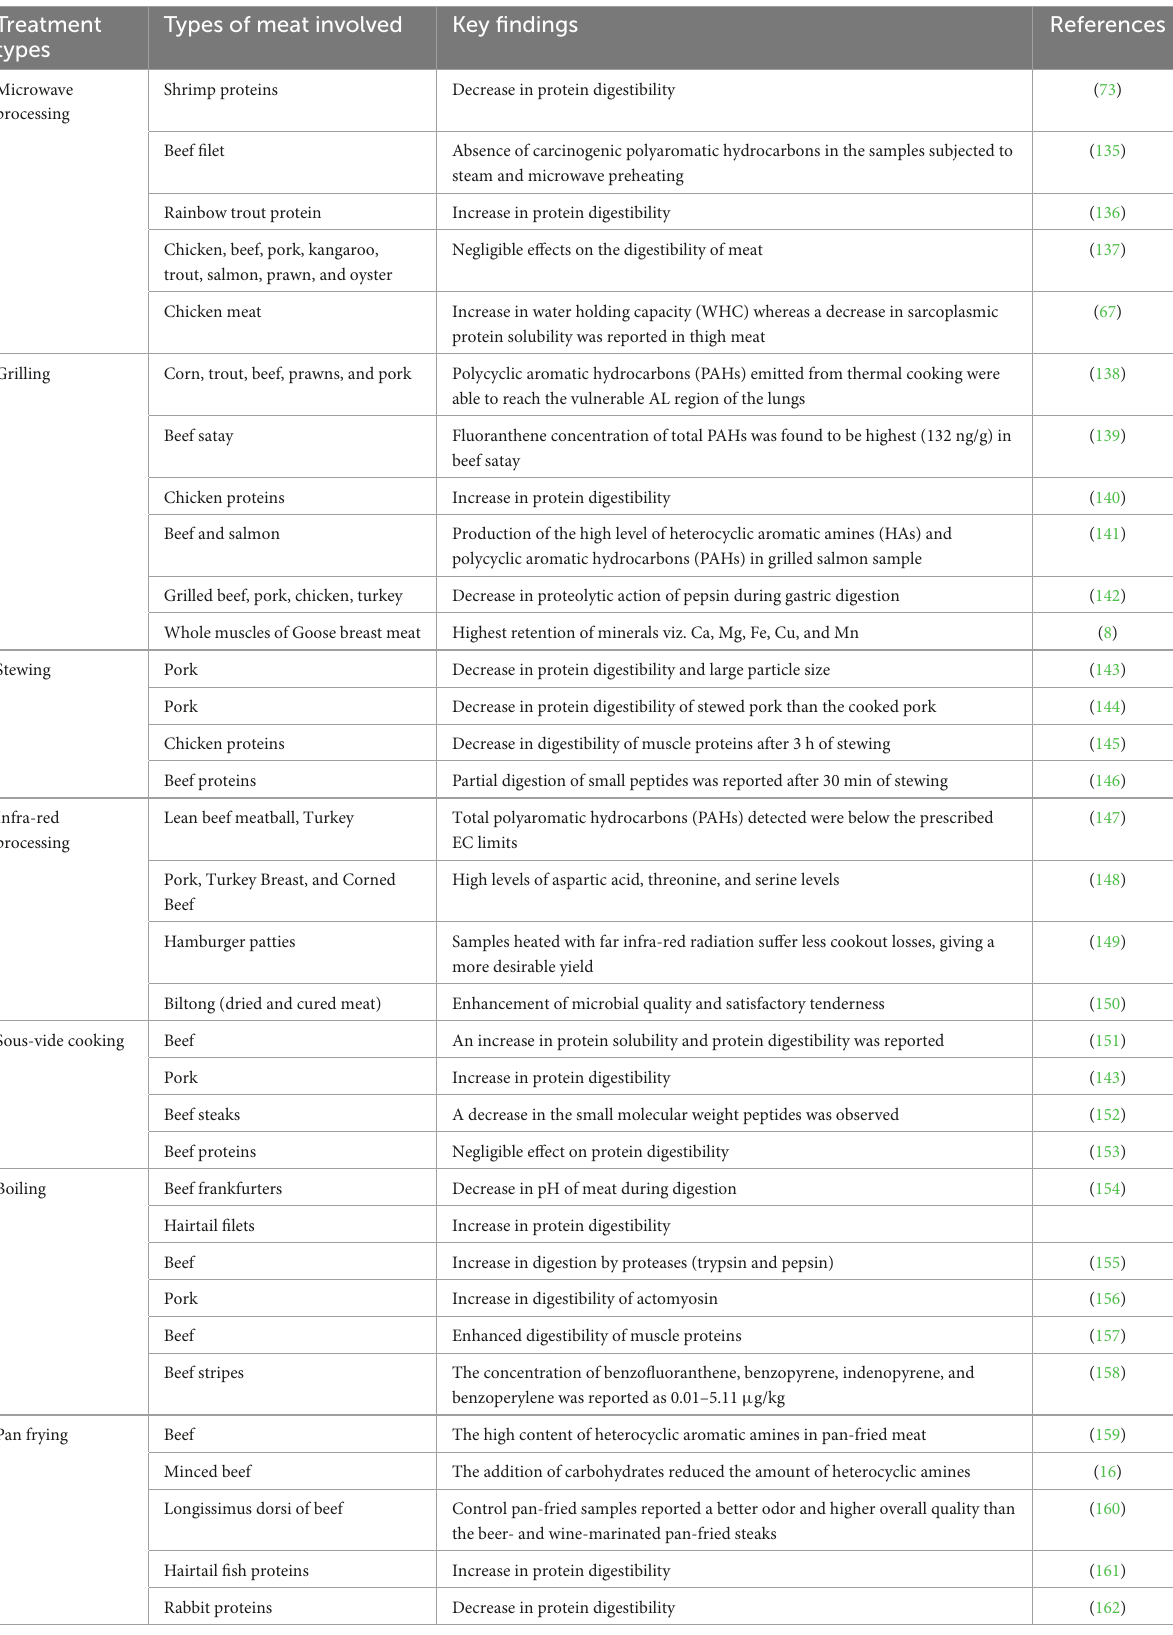
TABLE 1 Summary of the application of various thermal and non-thermal processing techniques on various types of